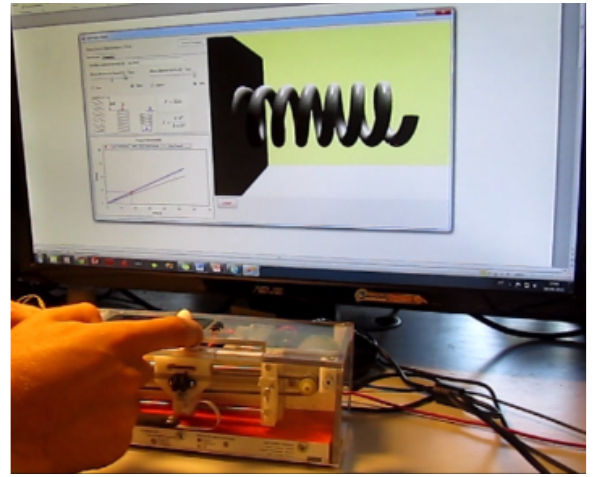
Figure 4. Virtual application with a haptic device for spring evalua- tion.